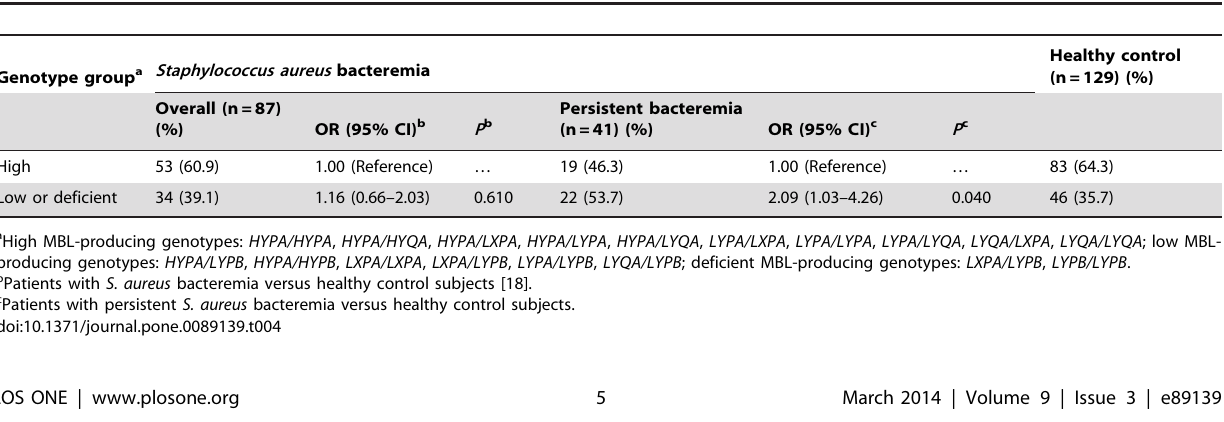
Table 4. Comparison of MBL2 genotype groups in patients with Staphylococcus aureus bacteremia or patients with persistent bacteremia versus healthy